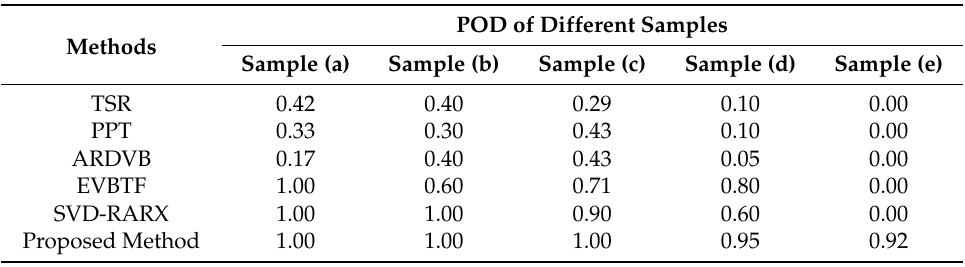
Table 3. Results of different detection methods evaluated by different samples.